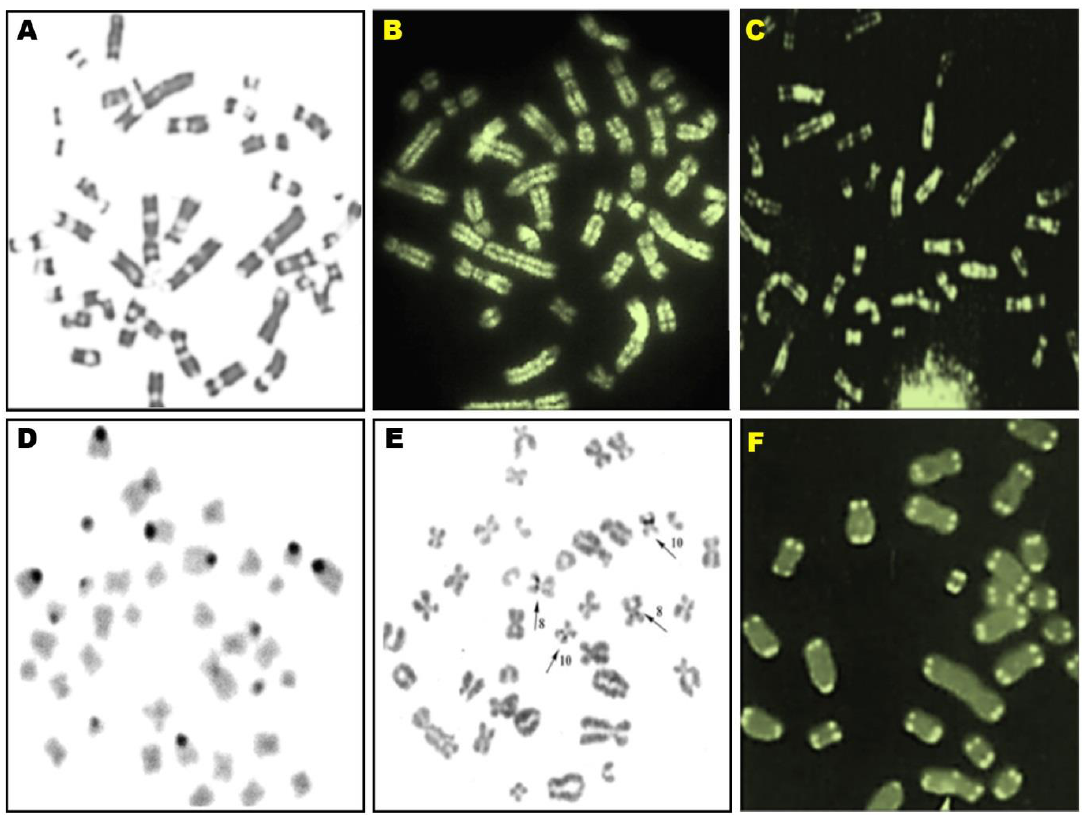
Figure 2. Pig metaphase chromosomes stained differentially using banding techniques G bands ( A ), Q bands ( B ), R bands ( C ), C bands ( D ), Ag-I bands ( E ), and T bands ( F ).